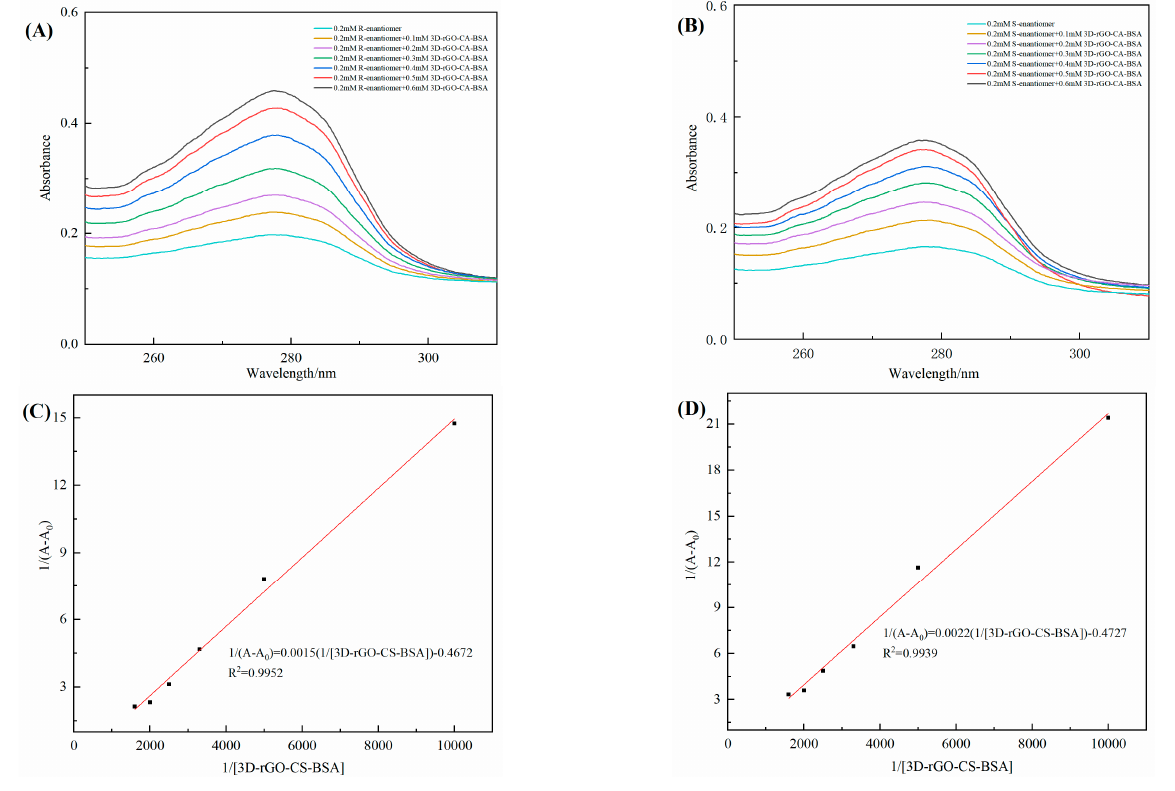
Figure 9. UV spectra of 0.2 mM R–enantiomer ( A ) and S–enantiomer ( B ) after adding distinct concentrations of 3D–rGO–CS–BSA (the amount–of–substance concentration of 3D–rGO–CS–BSA is replaced by the concentration of CS); double reciprocal plots of R–enantiomer ( C ) and S–enantiomer ( D ).